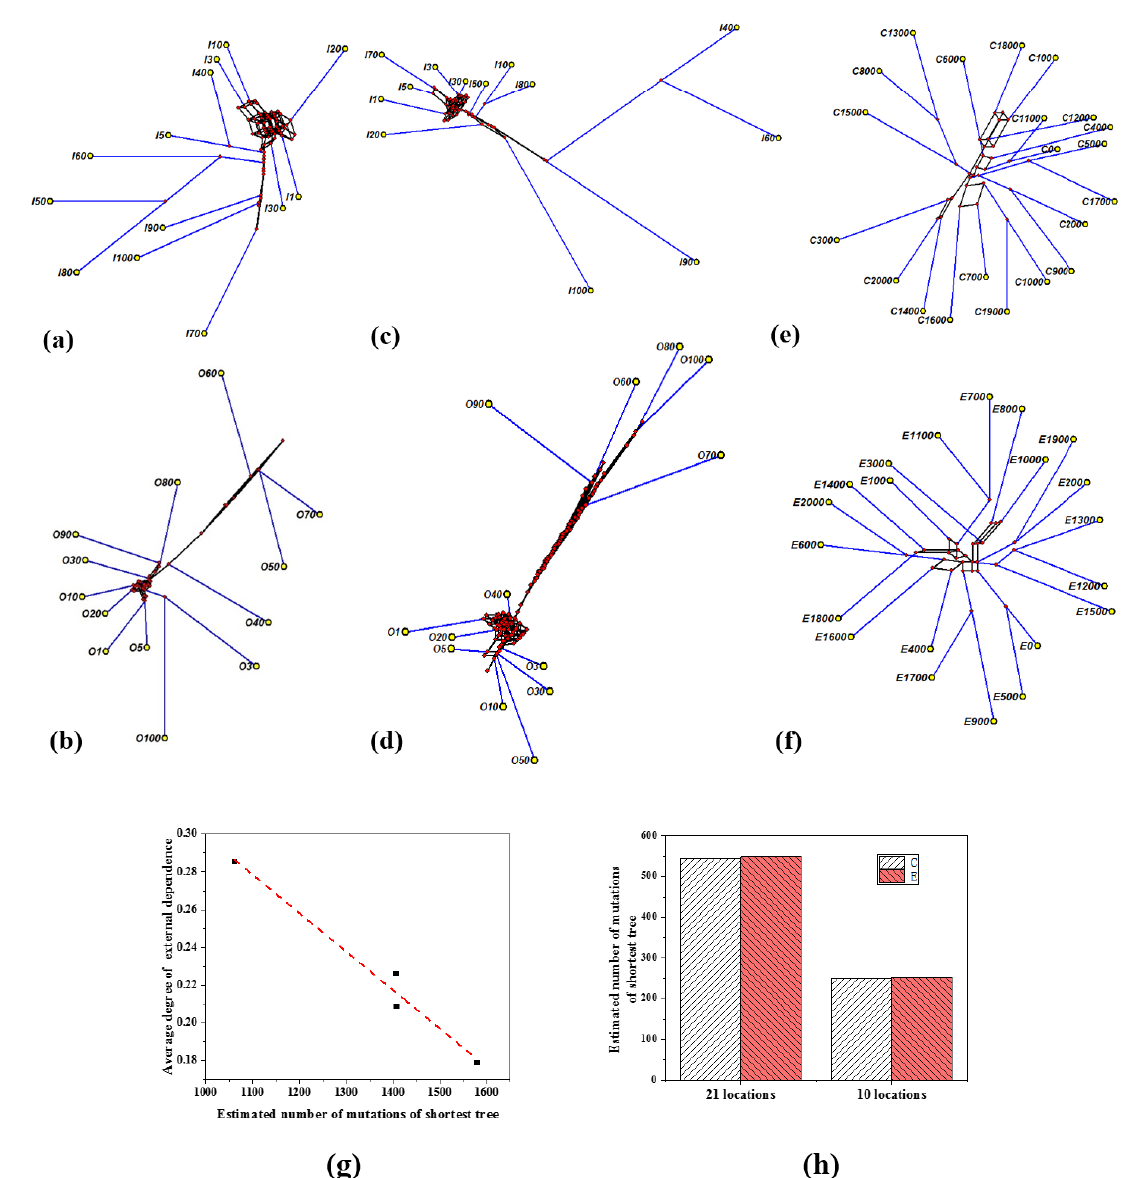
Figure 7. The phylogenetic trees of content difference during initial solidification in CC billets and 3D printing samples. ( a ) The phylogenetic tree in the inner curve side of the 20 ◦ C CC billet. ( b ) The phylogenetic tree in the outer curve side of the 20 ◦ C CC billet. ( c ) The phylogenetic tree in the inner curve side of the 35 ◦ C CC billet. ( d ) The phylogenetic tree in the outer curve side of the 35 ◦ C CC billet. ( e ) The phylogenetic tree in the columnar grain 3D printing sample with 21 locations. ( f ) The phylogenetic tree in the ultrafine equiaxed grain 3D printing sample with 21 locations. ( g ) The relationship between the estimated number of mutations of the shortest tree and average degree of the external dependence in different sides in CC billets. ( h ) The estimated number of mutations of the shortest tree with different locations for 3D printing samples. In the phylogenetic tree, the labels of the yellow points denote the locations in the ingots in Figures 1 and 3. The central structure constructed by red median vectors represents the tree torso. The blue line length represents the mutation number disregarding the torso; the longer the blue line, the larger the mutation number is between different locations, which indicates that it is more difficult to obtain the content distribution at a given location from that at another location. The estimated number of mutations of the shortest tree was obtained by comparing different numbers of mutation through different paths in a phylogenetic tree on the premise of connecting all